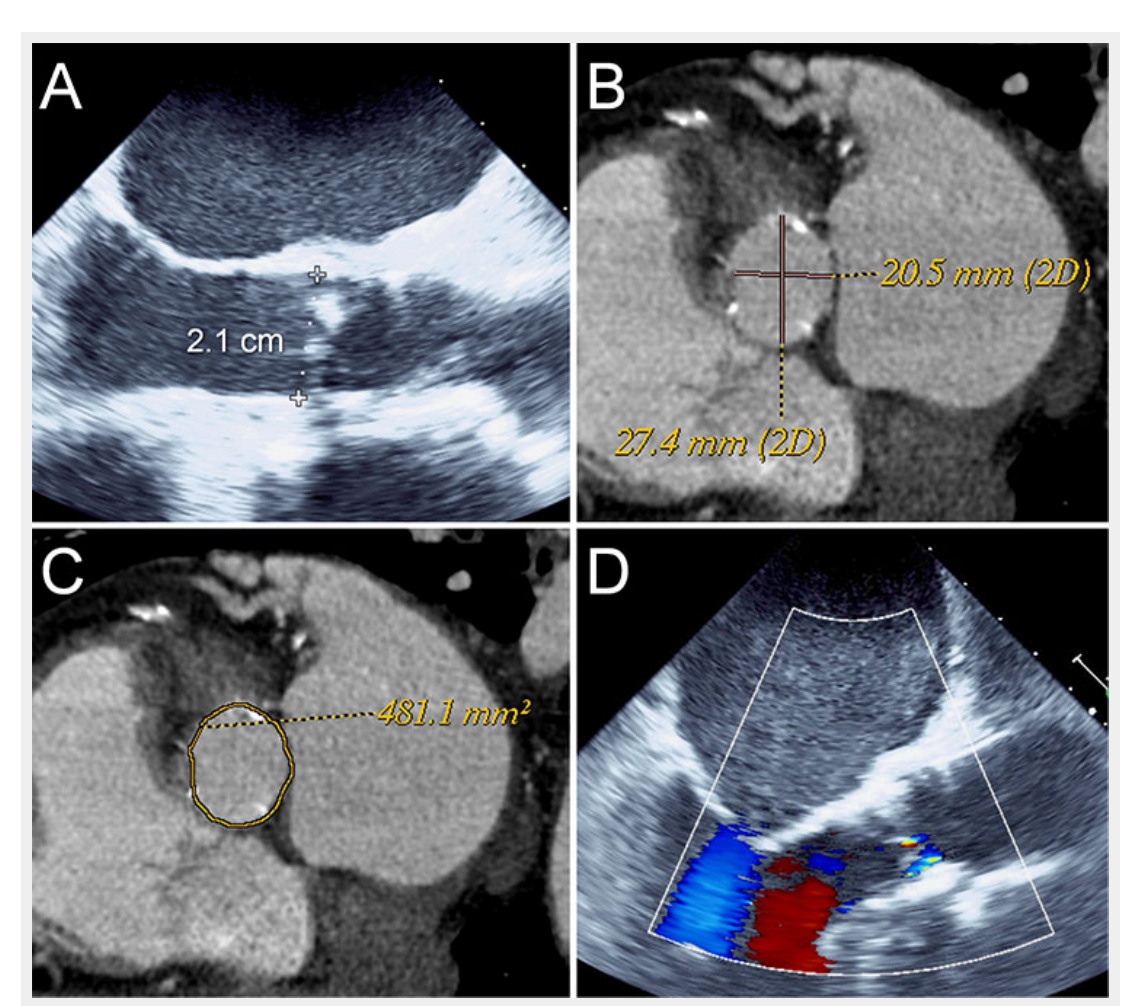
Figure 1 Annulus sizing using TEE and CT angiography. TEE measured an annulus of 2.1 cm suggesting a 23 mm Edwards Sapien or a 26 mm Medtronic CoreValve (A). CT angiography measured an area of 481 mm2 (C) and a mean diameter of 24 mm (B) suggesting a 26 mm Edwards Sapien or a 29 mm Medtronic CoreValve valve with ~10% oversizing. A 26 mm Edwards Sapien valve was implanted with trace paravalvular leak